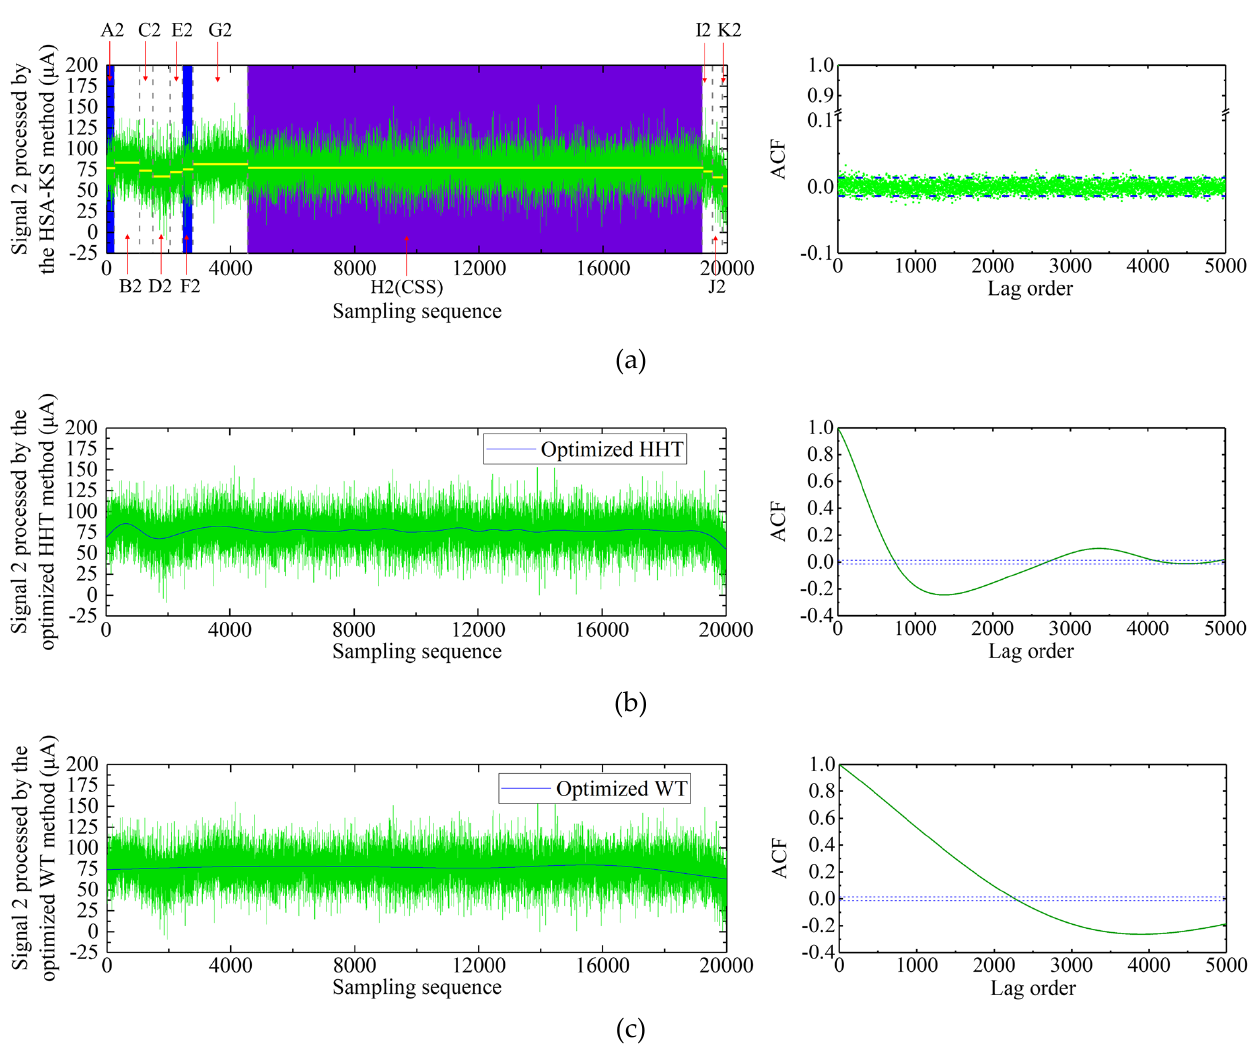
Figure 8. Results of signal 2 processed using the three different schemes: ( a ) HSA-KS method; ( b ) optimized HHT method; ( c ) optimized WT